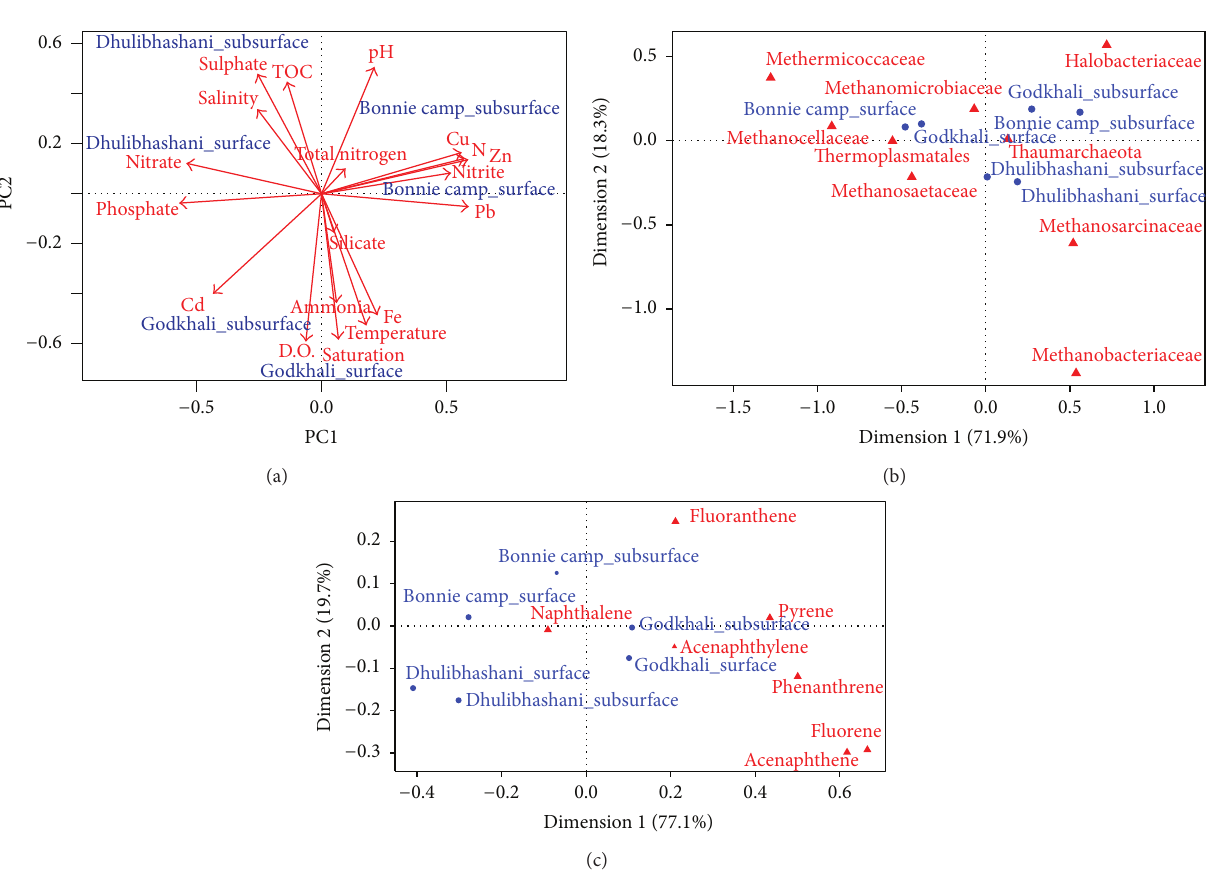
Figure 4: (a) Principal Component Analysis (PCA) of samples based on environmental parameters, nutrient, and heavy metal levels in the sediments samples. (b) Correspondence analysis (CA) based on distribution of major taxonomic lineages generated analyzing genomic data in the sediment samples. (c) Correspondence analysis (CA) based on distribution of polyaromatic hydrocarbons (PAH) in the sediment